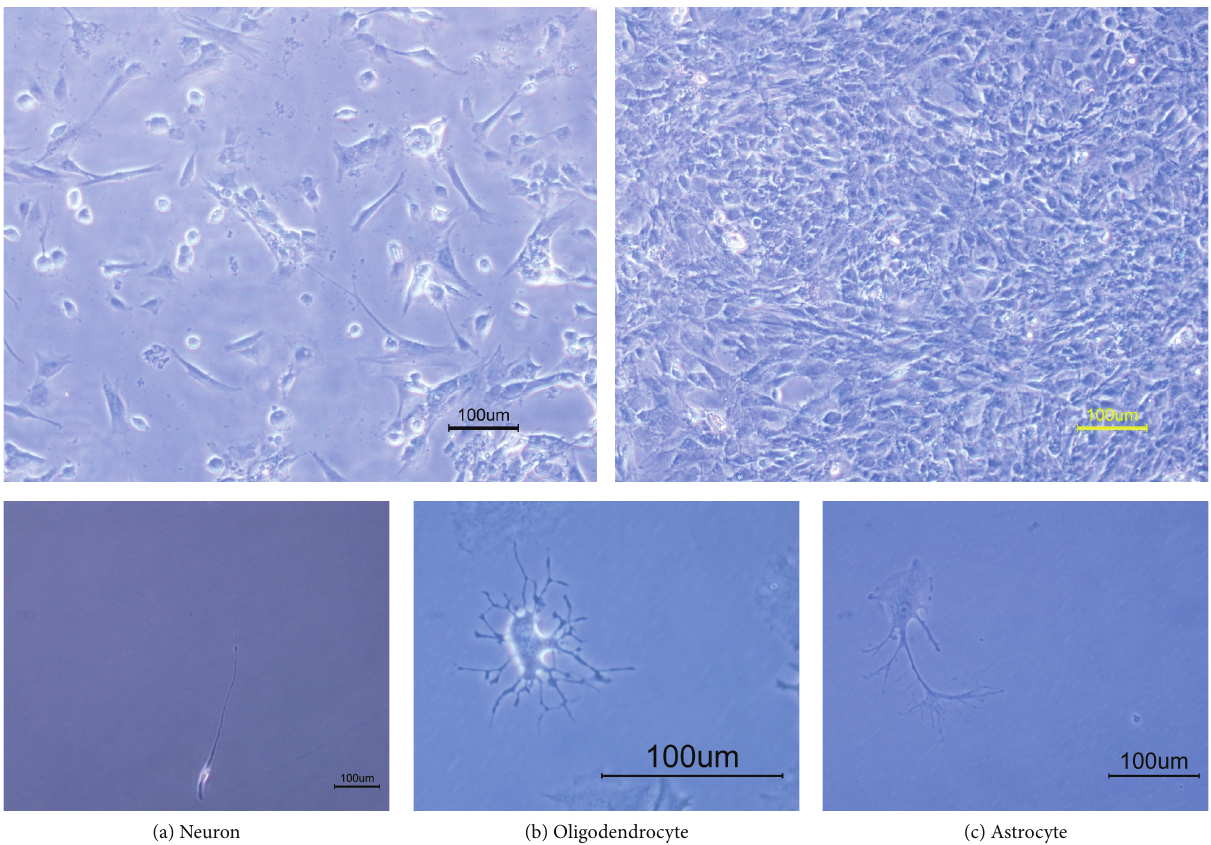
Figure 4: Inverted microscopy of the breast milk-derived cells differentiated toward three neural cell lineages.